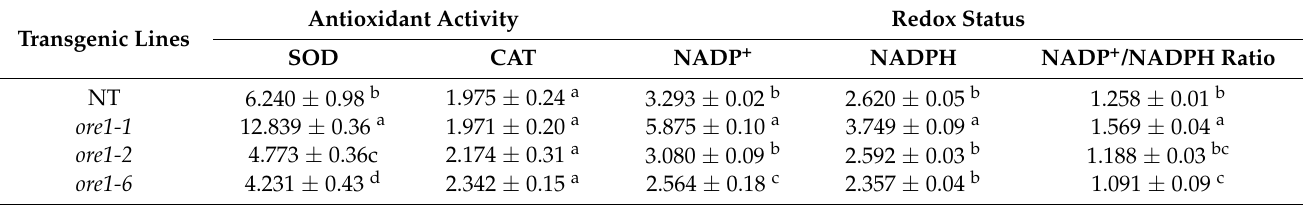
Table 3. Antioxidant activity and redox status in non-transgenic (NT) and transgenic soybean lines.